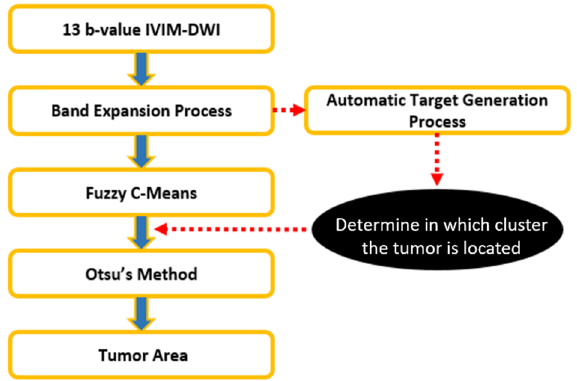
Figure 7. Flowchart of tumor detection via Fuzzy C-means.